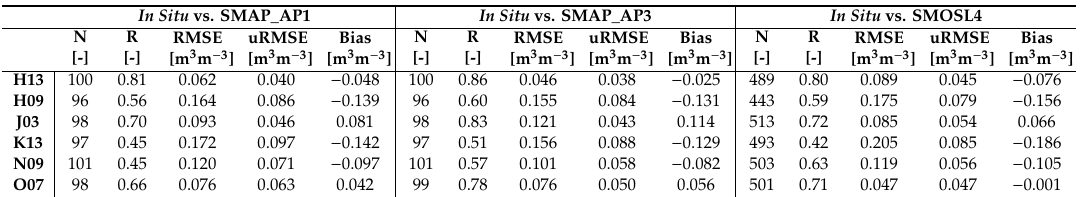
Table 5. Statistics obtained from the comparison of in situ SSM against the concurrent high-resolution